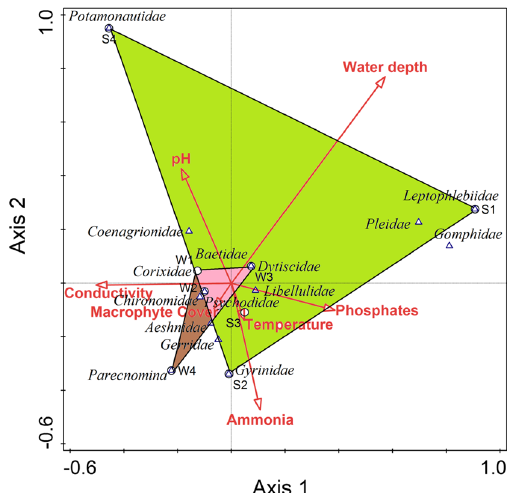
Fig. 5 Canonical correspondence analysis (CCA) showing the rela- tionship between environmental variables and macroinvertebrates. Polygons indicate the two seasons: green—summer and